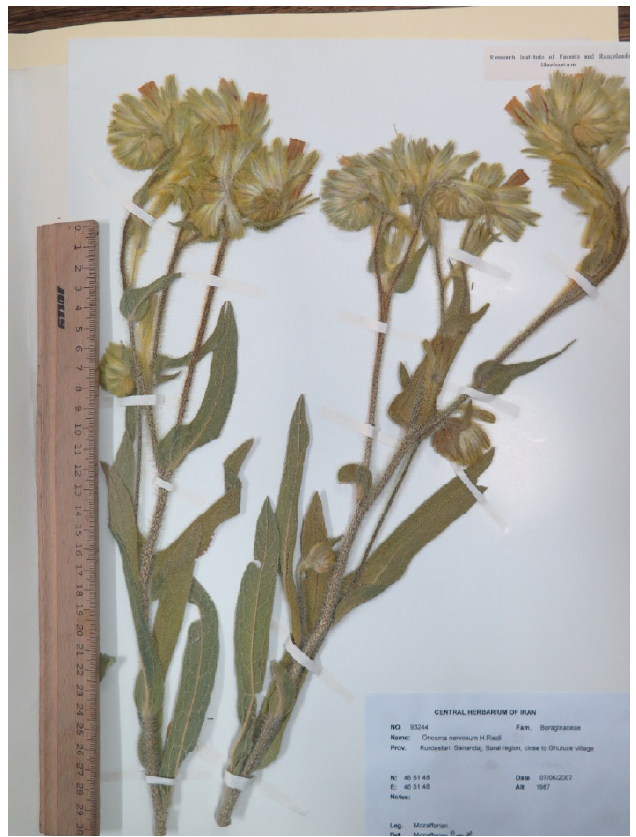
Figure 6. Onosma nervosa Riedl with purplish to black spots on stem.